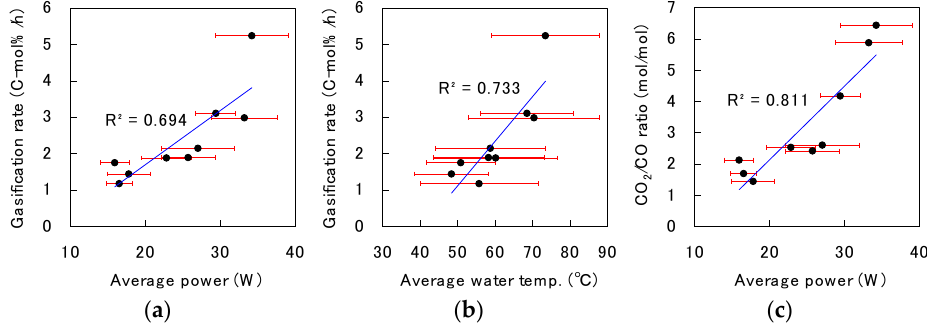
Figure 5. Gasification rate (the sum of CO and CO 2 yields per treatment time) of sucrose treated in solution plasma (10 g/L) as a function of the ( a ) average power and ( b ) average temperature. ( c ) CO 2 /CO ratio in the product gas as a function of the average power. Error bars indicate sample standard deviations for power and water temperature distributions.